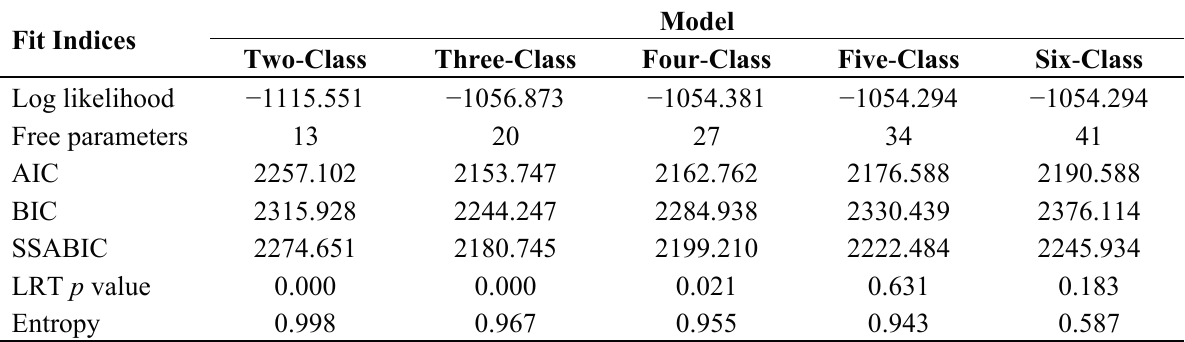
Table 1. Fit indices for the latent class analysis of smoking behaviors.